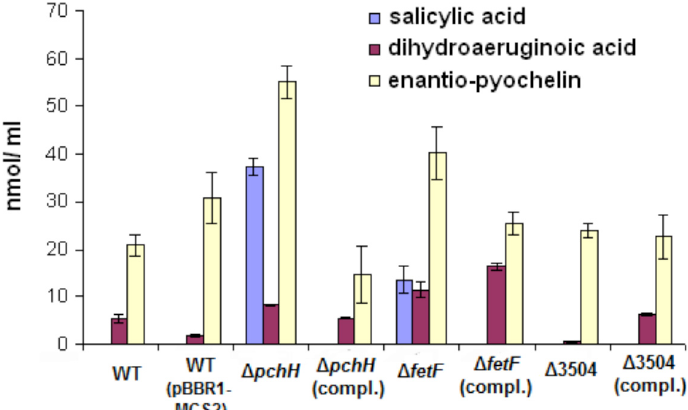
Fig 2. Concentrations of E-Pch, DHA and SA in culture supernatants of P . protegens strains determined by HPLC. Levels of E-Pch presented are combination of both E-Pch diastereoisomers. Error bars represent standard deviations between three biological replicates. Strains tested were P . protegens Pf-5 (wildtype) and mutants of Pf-5 having deletions in putative transporter genes ( Δ pchH , Δ fetF , and Δ 3504) as well as mutants complemented (labeled as ‘ compl. ’ ) with the corresponding gene in the plasmid vector pBBR1-MCS2. The label ‘ WT (pBBR1-MCS2) ’ indicates wild-type strain with control